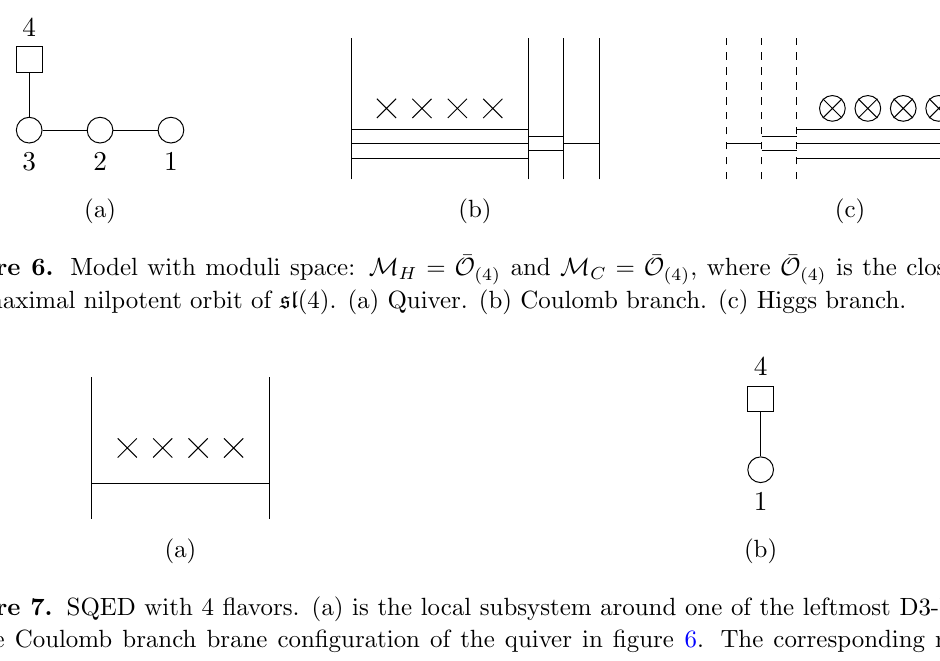
Figure 5. Self-dual quiver theory. The Higgs and the Coulomb branch of this theory are both (cid:22) O , i.e. the closure of the maximal nilpotent orbit of g = sl ( n ). ( n )